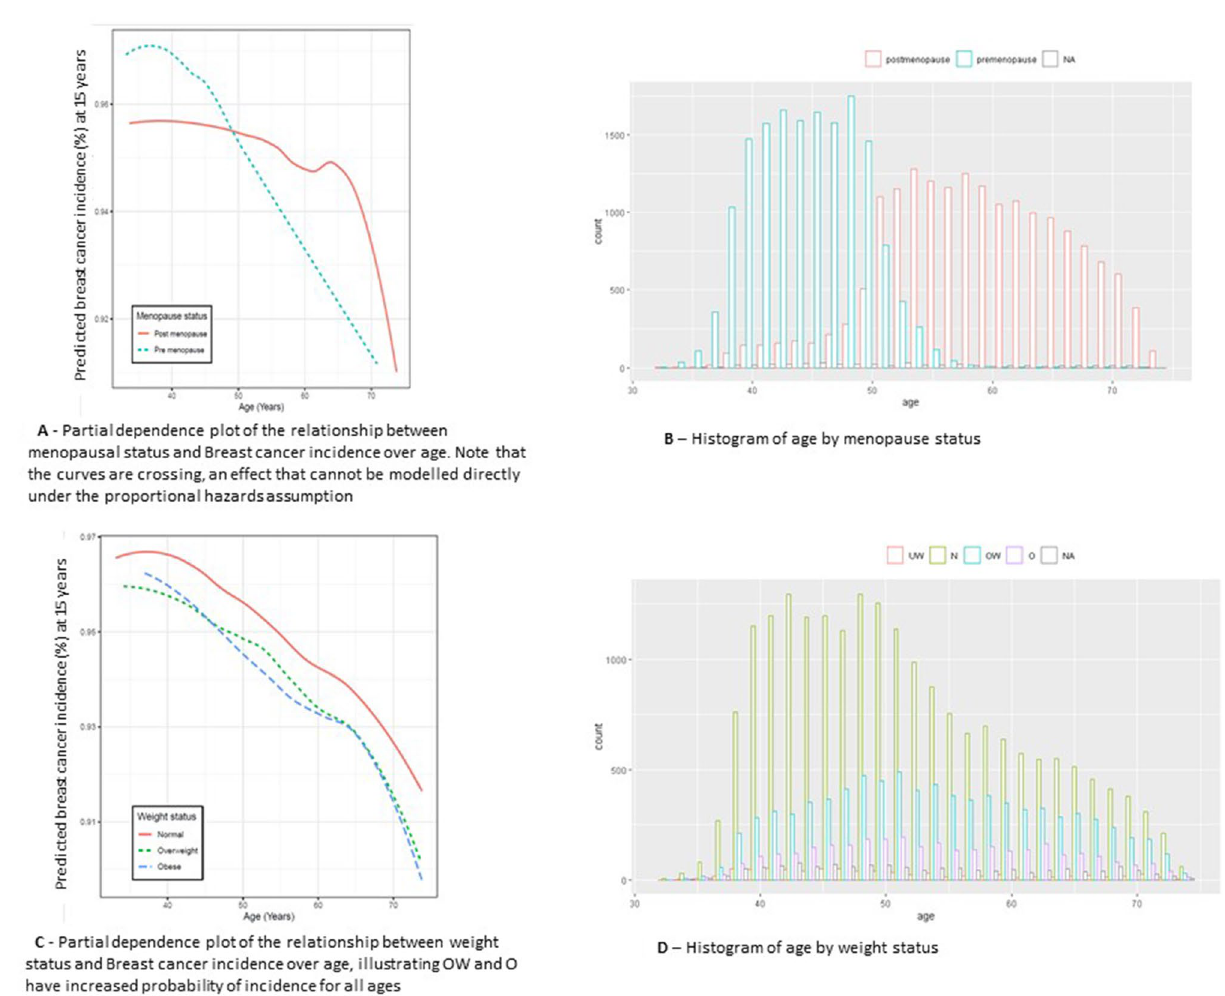
Figure 2. ( A ) Partial dependence plot of the relationship between menopausal status and Breast cancer incidence over age. Note that the curves are crossing, an effect that cannot be modelled directly under the proportional hazards assumption; ( B ) Histogram of age by menopause status; ( C ) Partial dependence plot of the relationship between weight status and Breast cancer incidence over age, illustrating OW and O have increased probability of incidence for all ages; ( D ) Histogram of age by weight